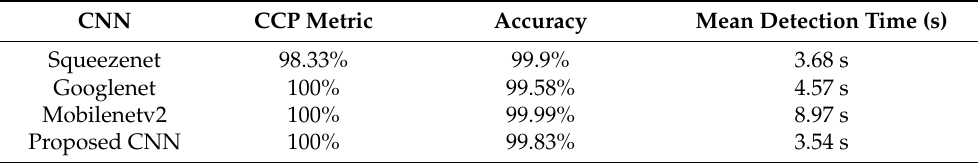
Table 5. RCNN detector obtained results.